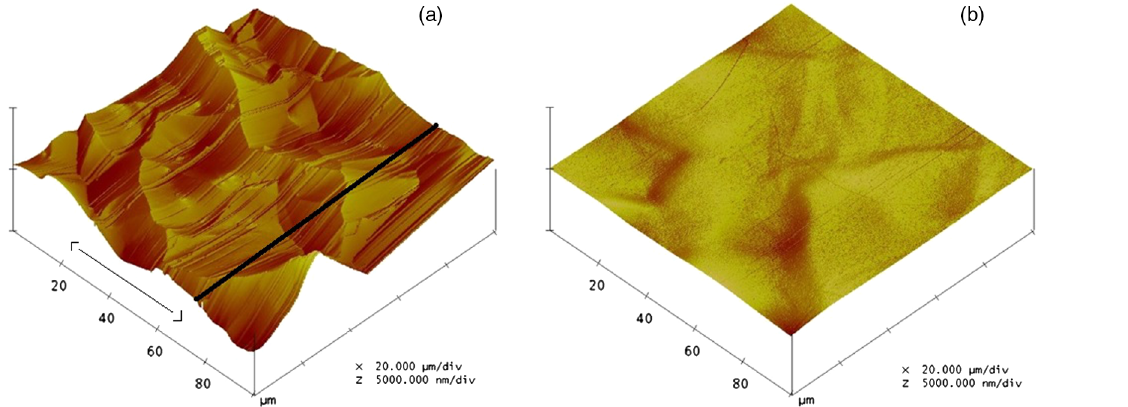
FIG. 13. AFM images from a fine grain niobium sample with (a) ∼ 100 μ m removal by BCP, (b) after electropolished at 30 °C to remove 48 μ m. Horizontal scale is 20 μ m per division and vertical scale is 5 μ m per division